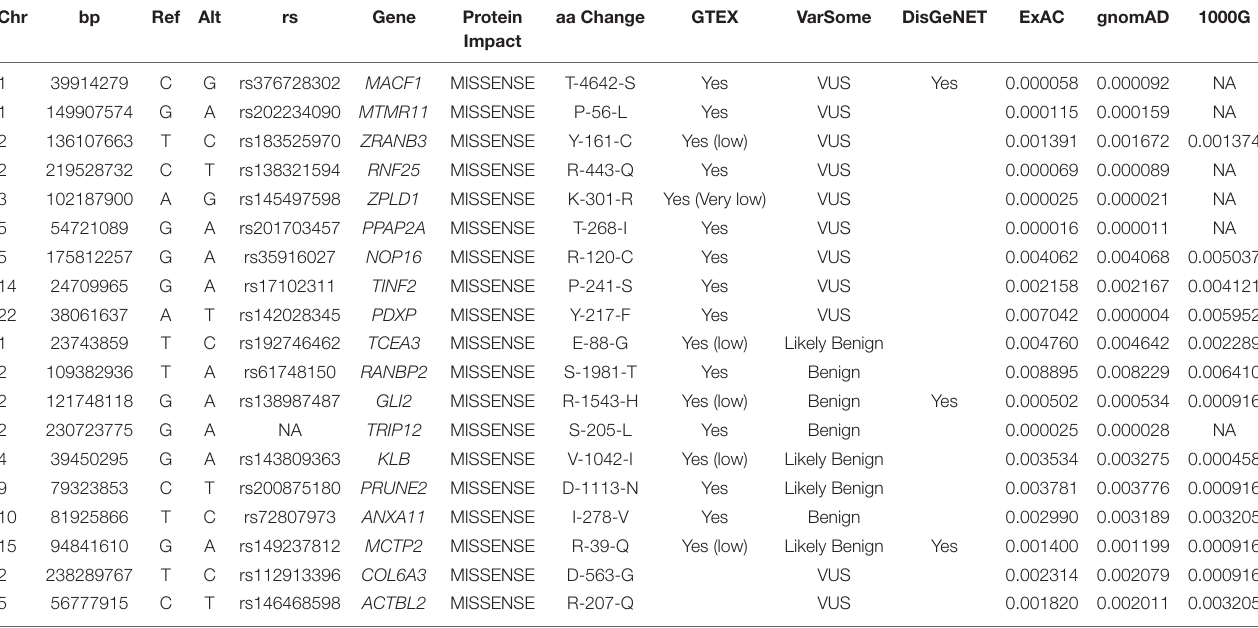
TABLE 1 | Rare non-synonymous variants identified in conserved regions by WES shared only among affected